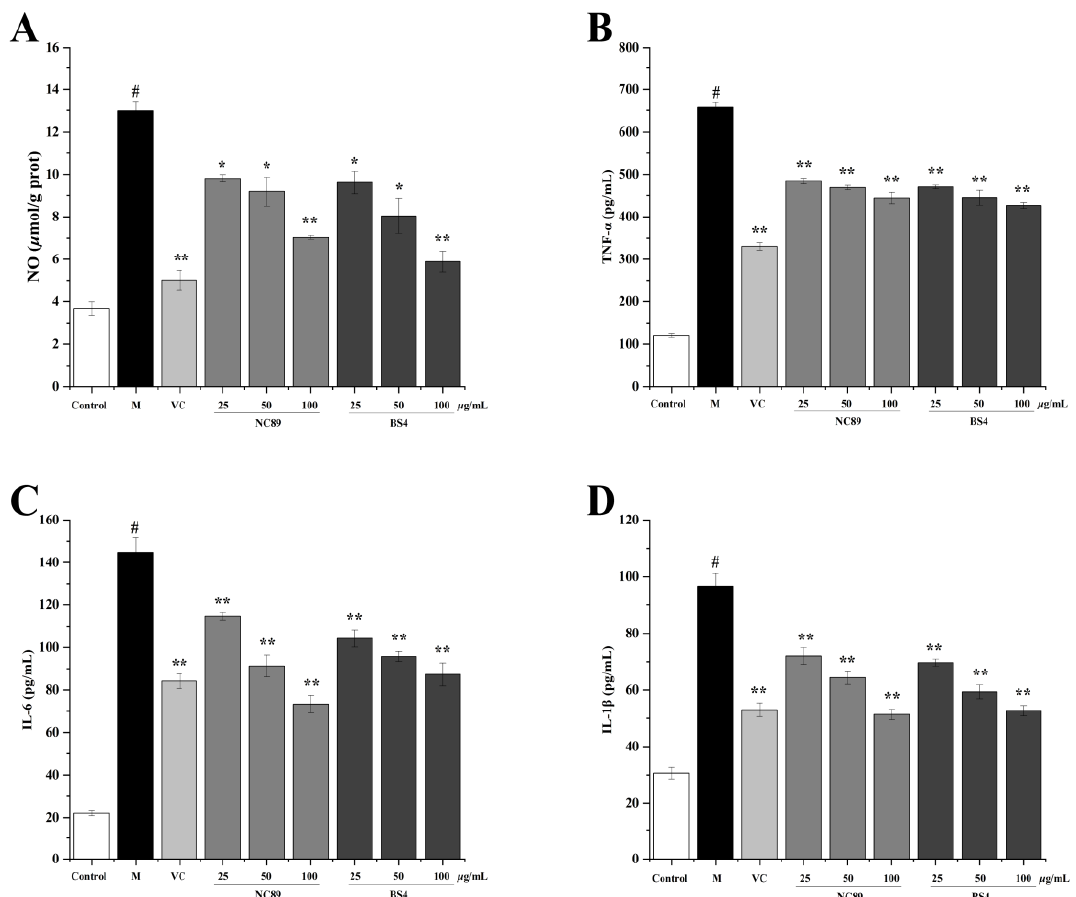
Figure 6. Effects of NC89 and BS4 tobacco seed oils on the secretion of NO, TNF- α , IL-6 and IL-1 β in LPS-induced RAW264.7 cells. The levels of NO ( A ), TNF- α ( B ), IL-6 ( C ), and IL-1 β ( D ) were evaluated by kit. Values are presented as the mean ± SD ( n = 3). # p < 0.05 vs. Control group; * p < 0.05, ** p < 0.01 vs. M group.